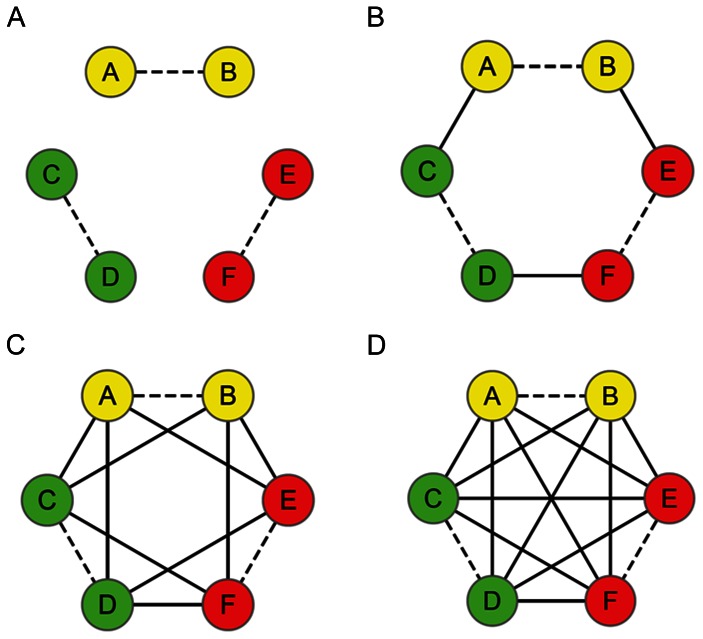
Illustration of PIS calculation.Suppose miRNA i targets genes a, b, c and d that encode protein A, B, C and D, respectively; miRNA j targets genes a, b, e and f that encode protein A, B, E and F, respectively. The six proteins can be divided into three clusters according to diverse miRNA regulations, that is, protein A and B (yellow nodes, regulated by both miRNA a and b); protein C and D (green nodes, regulated by miRNA a only); protein E and F (red nodes, regulated by miRNA b only). Four possible conditions of functional association between protein clusters were compared by calculating PIS. PIS is equal to the sum of proteins (n = 6) divided by the sum of protein-protein interactions (PPIs) between protein clusters. A. No functional association between protein clusters (0 PPI, PIS = 0); B. Weak functional association between protein clusters (3 PPIs, PIS = 0.50); C. Moderate functional association between protein clusters (9 PPIs, PIS = 1.50); D. The highest level of functional association between protein clusters (12 PPIs, PIS = 2.00). The dash and solid edges represent PPIs inside and between protein clusters, respectively. PIS: protein interaction score.